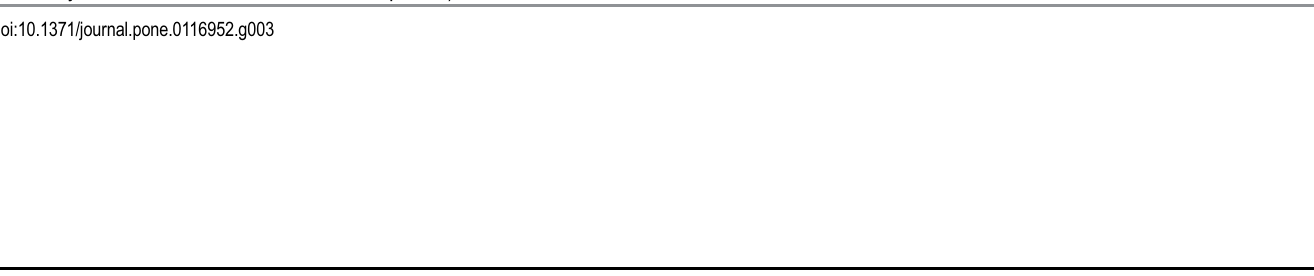
PLOS ONE | DOI:10.1371/journal.pone.0116952 January 9,